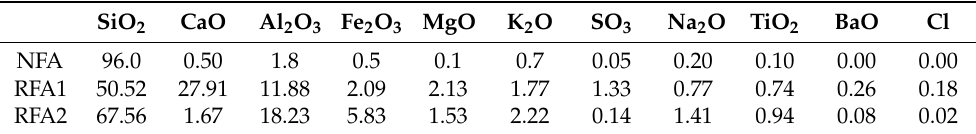
Table 4. Chemical composition of recycled fine aggregate (%).